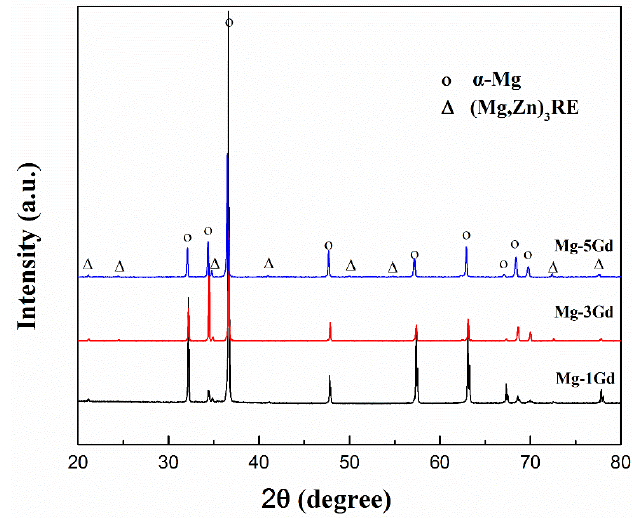
Figure 5. The XRD pattern of Mg-xGd alloys after solution treatment.